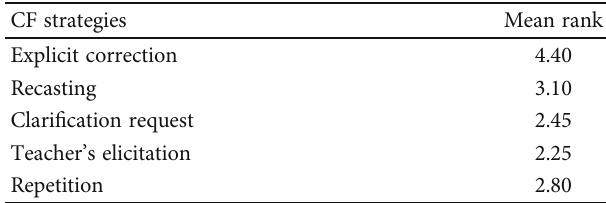
Table 1: The ranks of CF strategies done by the teachers.